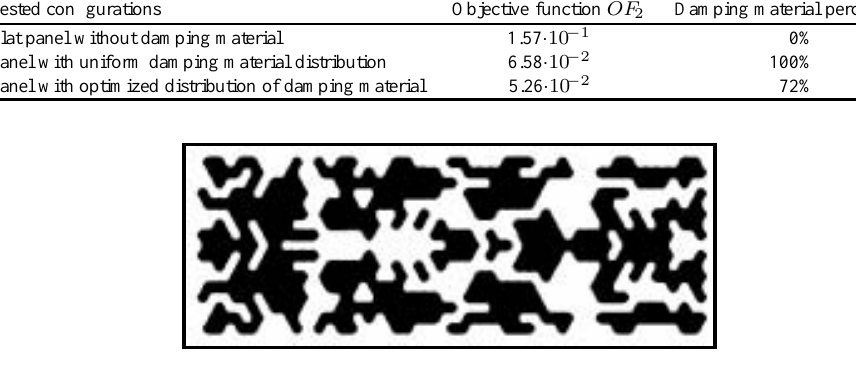
Fig. 7. reference panel F.E. model.